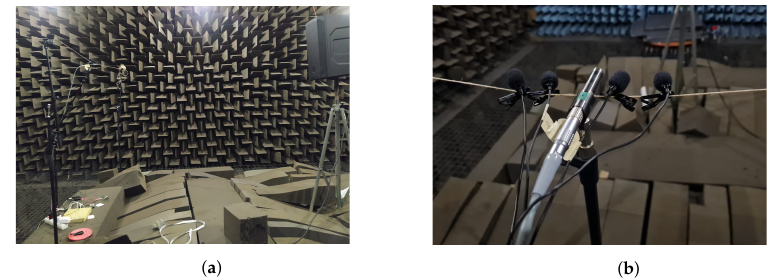
Table 1. Calibration factors obtained for the different microphones. Gv1 Gv2